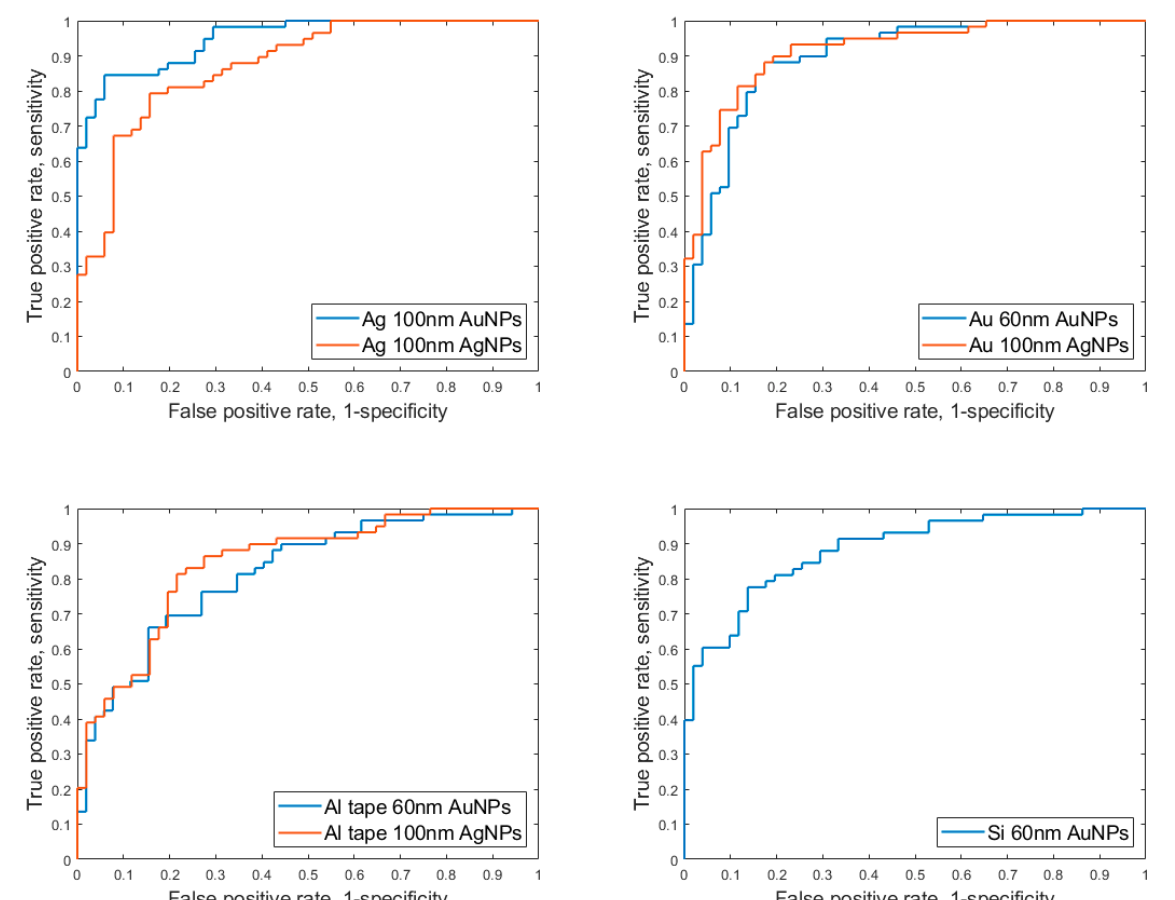
Figure 6. ROC curves for all experimental sets when PC components number is 25.